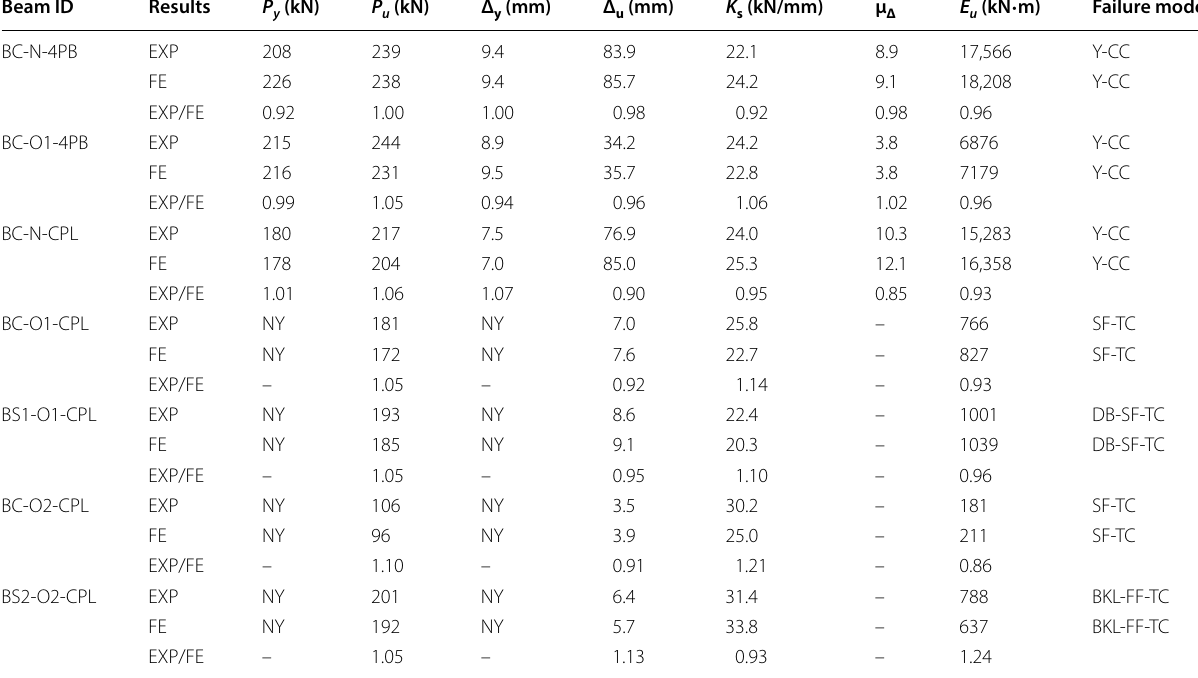
P y and Δ y load and mid-span deflection at yielding of bottom steel rebars, P u ultimate load, Δ u mid-span deflection at ultimate state, K s effective pre-yield stiffness, μ Δ deflection ductility ratio Δ u /Δ y , E u energy dissipated at ultimate state, Y-CC bottom steel yielding followed by concrete crushing at mid-span, SF-TC shear failure of = top chord, DB-SF-TC FRP debonding followed by shear failure of top chord, BKL-FF-TC out-of-plane buckling of steel plates followed by flexural failure of top chord, EXP experimental, FE finite element, NY no steel